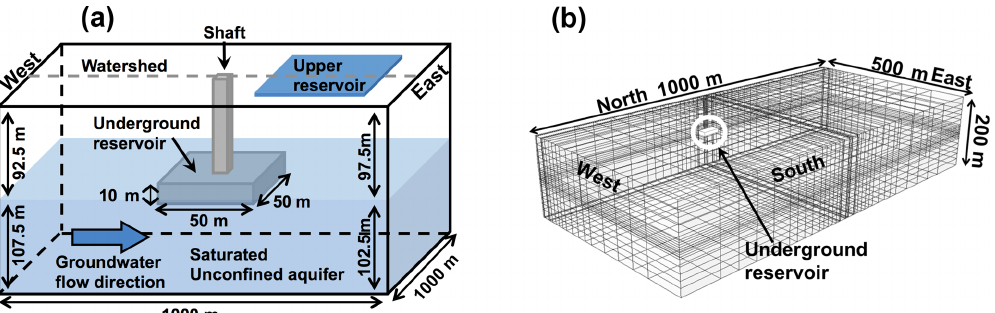
Figure 1. General view of the problem (a) and the whole modelled domain (b)